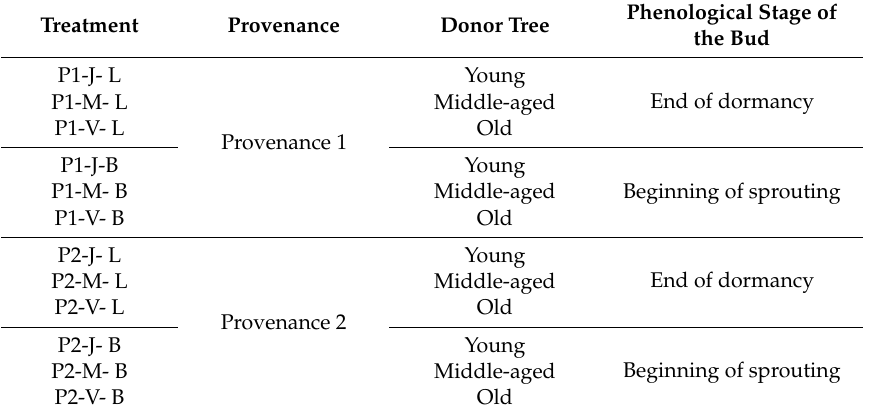
Table 2. Treatments evaluated for Pinus engelmannii Carr.